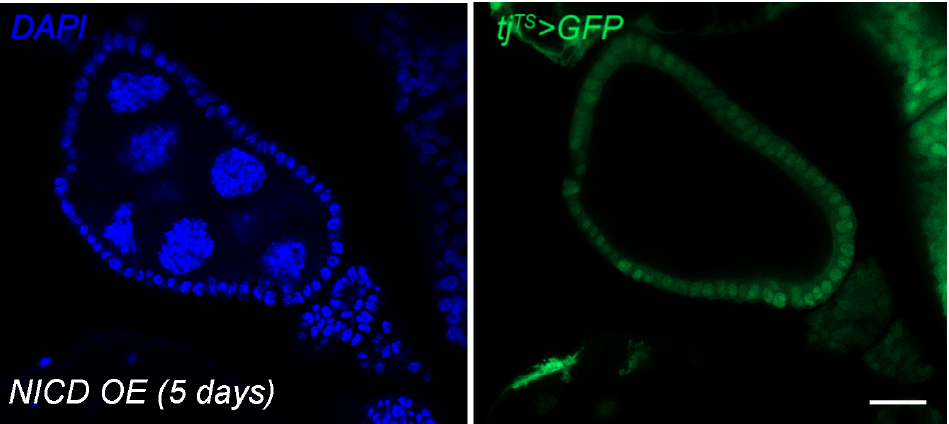
Figure A4. NICD overexpression in the follicle cells after five days in 29 ◦ C. Mid-stage egg chamber from NICD OE genotype following five days in 29 ◦ C for allograft experiment. Similar to three days in 29 ◦ C, there is no tumor formation. Scale bar = 10 µ